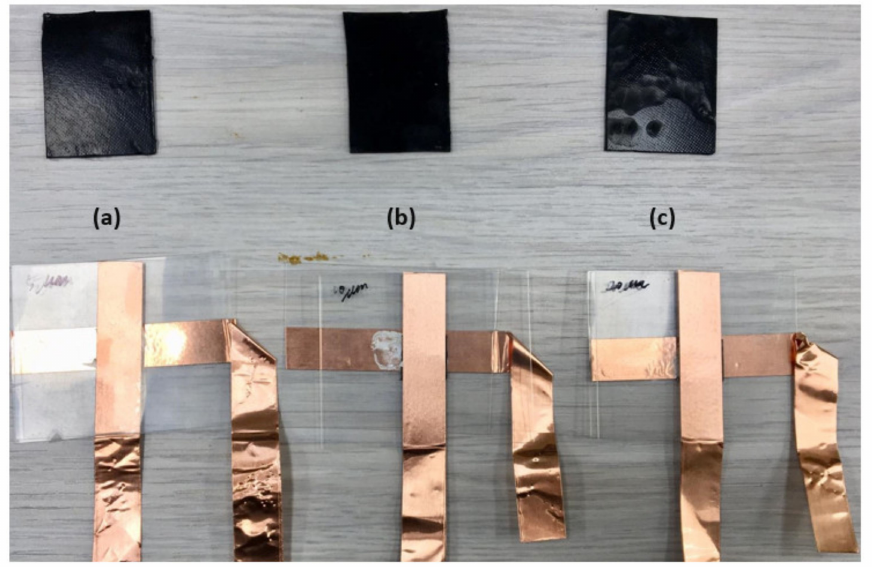
Figure 6. Pressure-sensitive polymer composites and their assembly for pressure sensitivity mea- suring equipment. ( a ) TPU-(MWCNT-PMMA) (5 µ m), ( b ) TPU-(MWCNT-PMMA) (10 µ m), and ( c ) TPU-(MWCNT-PMMA) (20 µ